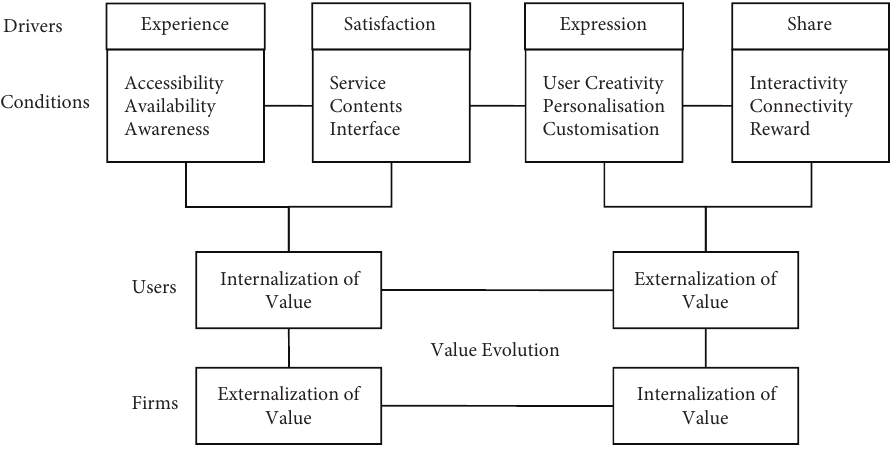
Figure 1. Drivers and conditions of business and value co-creation in social